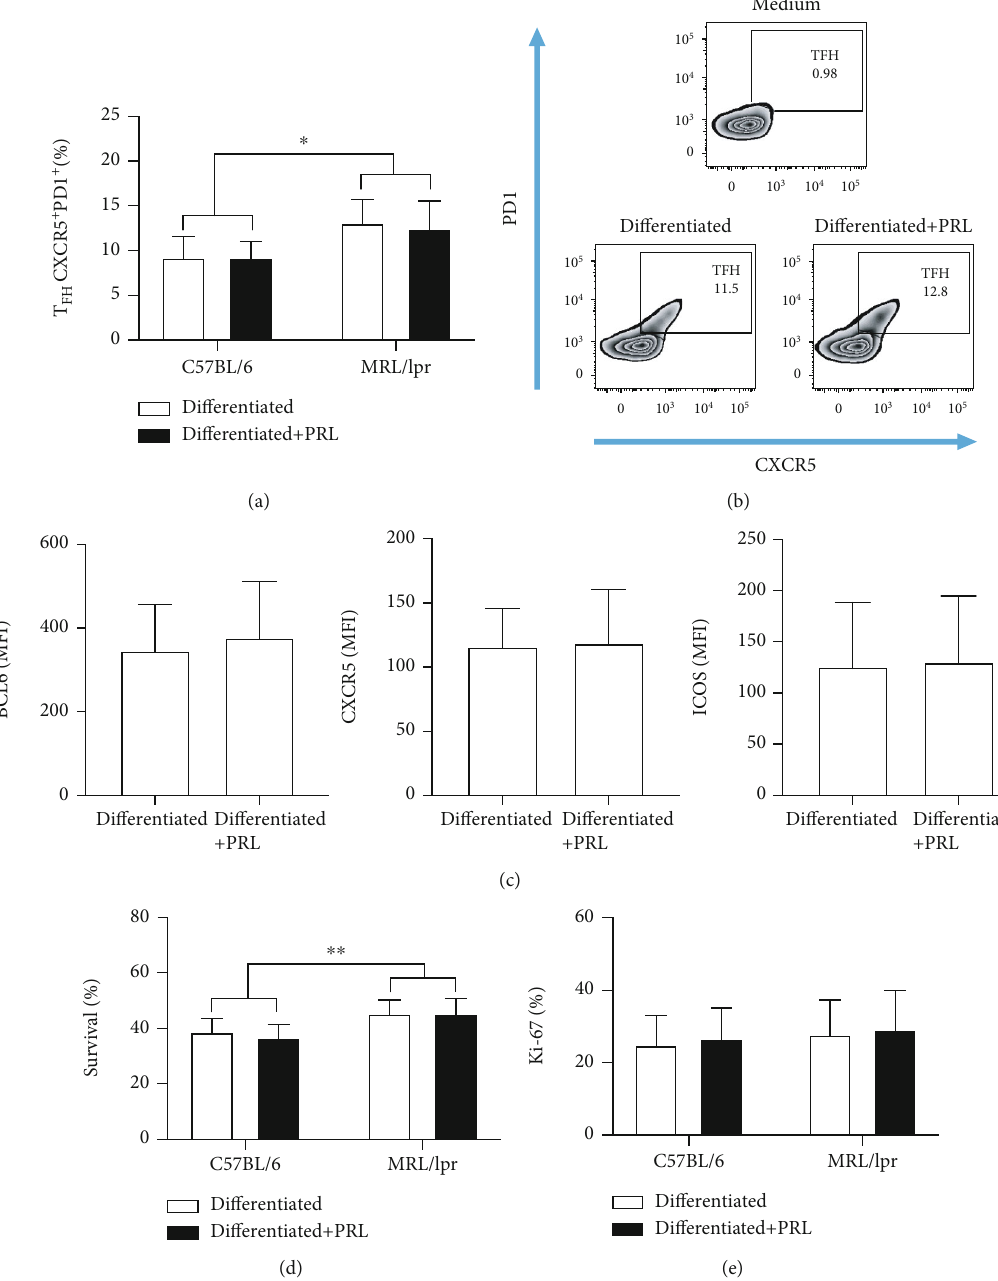
Figure 4: Di ff erentiation and survival of T cells in the presence of PRL. T cells from 9-week-old C57BL/6 and MRL/lpr mice were FH naïve puri fi ed by MACS and di ff erentiated to T in the presence and absence of PRL for 48h, before staining with a viability marker (Ghost FH Red) and anti-Ki-67, anti-CD4, anti-CXCR5, anti-BCL6, and anti-ICOS antibodies. The surface CXCR5 + PD1 + population represents T cells. (a) Percentage of di ff erentiation to T in vitro. (b) Zebra plot of one representative experiment. (c) Expression of BCL6, CXCR5, FH cells. (d) Percentage of T cell survival. (e) Percentage of proliferation (Ki-67 + ). Six di ff erent experiments were and ICOS (MFI) in T FH FH performed; each experiment was done in triplicate. Pooled data are presented as the mean ± SD ; ∗∗ p < 0 : 01 and ∗ p < 0 : 05 using